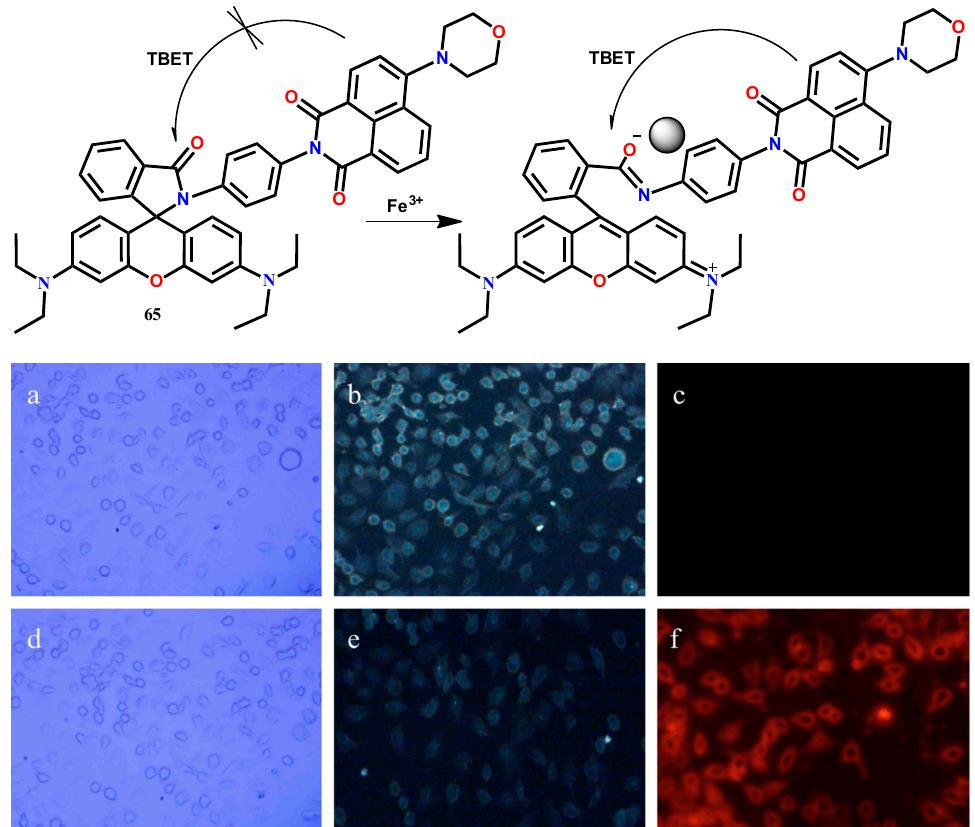
Figure 7. Images of EC109 cells treated with the ratiometric 65 : ( a ) bright-field image of EC109 cell incubated with 65 (5 μ M); ( b ) fluorescence image from green channel; ( c ) fluorescence image from red channel; ( d ) bright-field image of EC109 cell incubated with 65 (5 μ M) for 15 min, and then further incubation with Fe 3+ (5 μ M) for 15 min at 37 °C; ( e ) fluorescence image from green channel; ( f ) fluorescence image from red channel (Reproduced from Ref. [73] with permission from Elsevier).